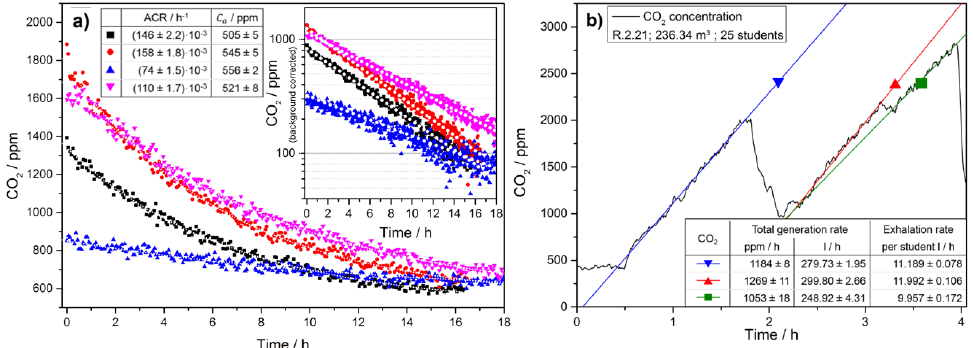
Figure 4. ( a ) CO 2 decay curves measured at different times in the same classroom and the nonlinear regression curves used to estimate the background concentration ( C a ). The fit results are stated in the table in the inset. The inset on the right shows a logarithmic representation of the CO 2 concentration values after subtraction of the background value C a to highlight the exponential decay behavior. ( b ) With closed class room doors the ventilation rate may be neglected as compared to the generation rate, which is why linear models apply. It also allows for determining the level of physical activity via the generation rate of CO 2 during class. Knowing the volume of the room and the number of people inside allows for estimating the activity level, which may vary according to the specific activity performed in class.